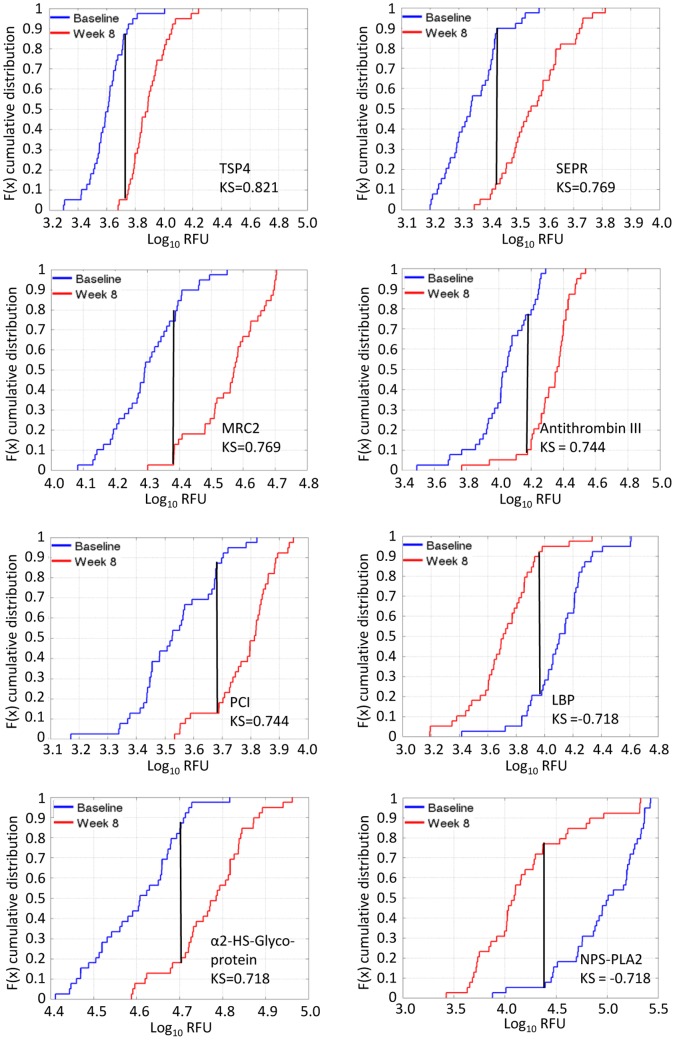
Empirical cumulative distribution functions showing Log RFU for the eight proteins with largest KS distances between baseline and week 8.